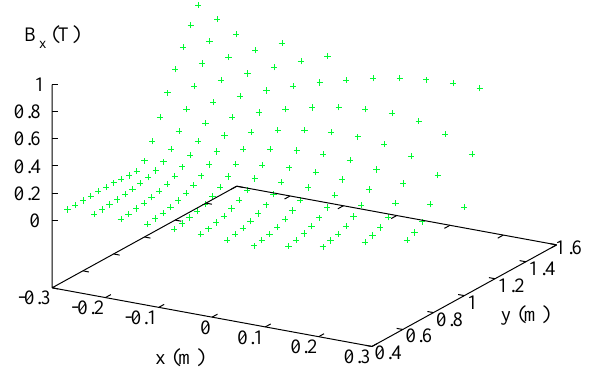
FIG. 4. (Color) Variation of (cid:66) (cid:120) (cid:115) (cid:120) (cid:44) (cid:121) (cid:100) , just before the bend, in Cartesian coordinates.